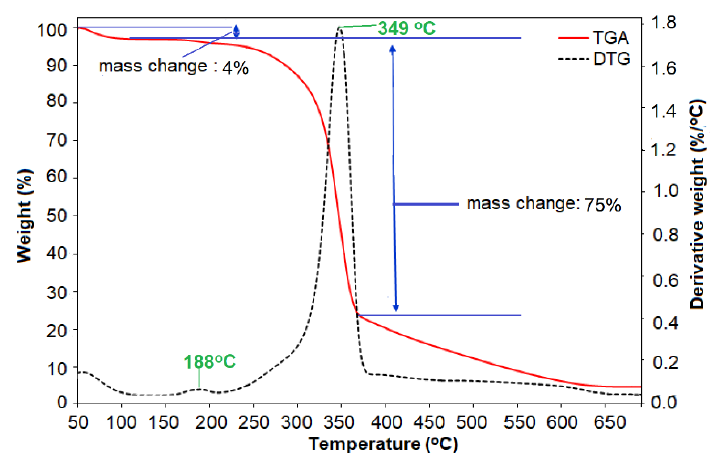
Figure 12. DTG curves of C. pentandra / Ag-NPs a function of temperature.